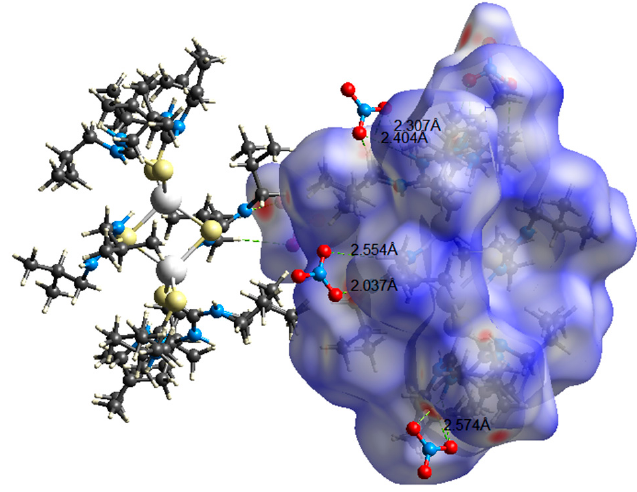
Figure 8. View of the three-dimensional Hirshfeld surface of 2 plotted over d norm in the range − 0.4382 to 1.6504.